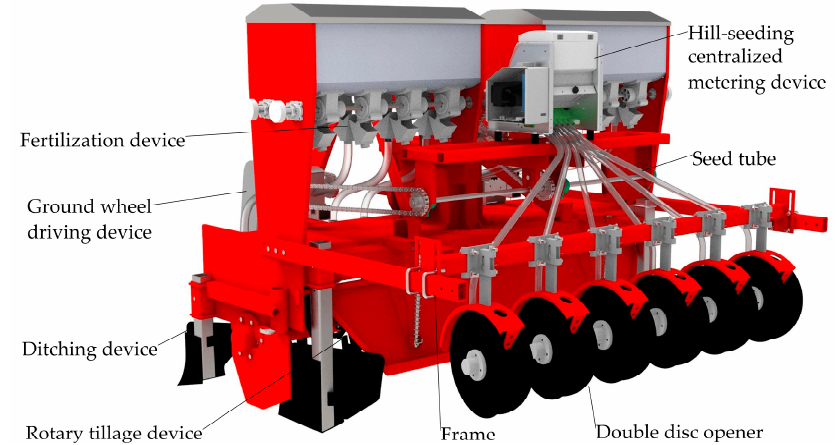
Figure 1. Structural diagram of planter.